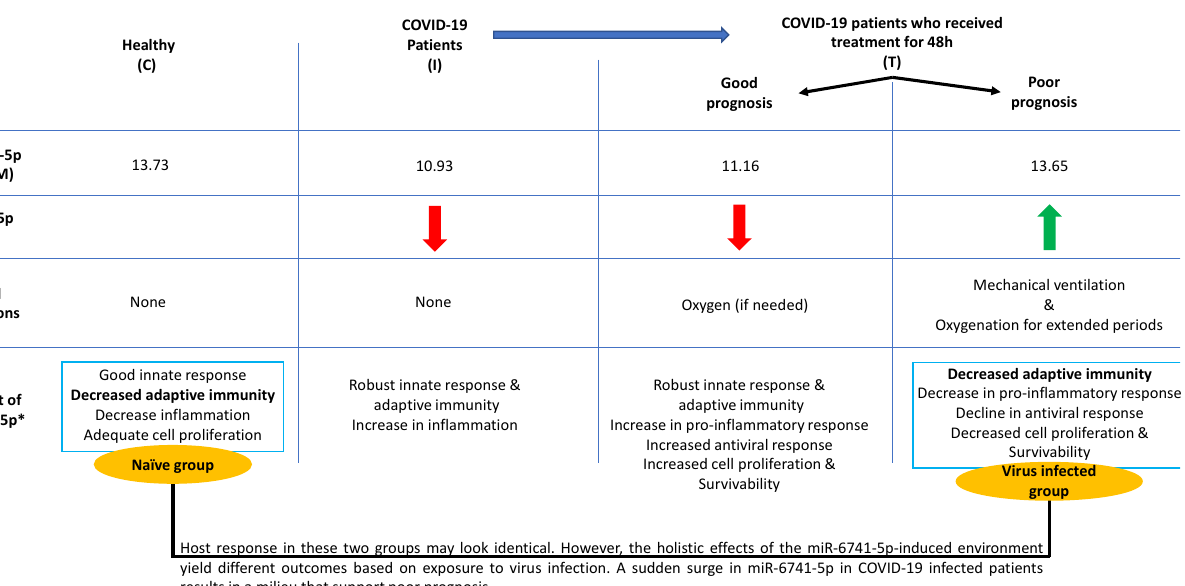
Figure 4. A schematic model describing the working hypothesis. * refer to Supplemental Figure S4.